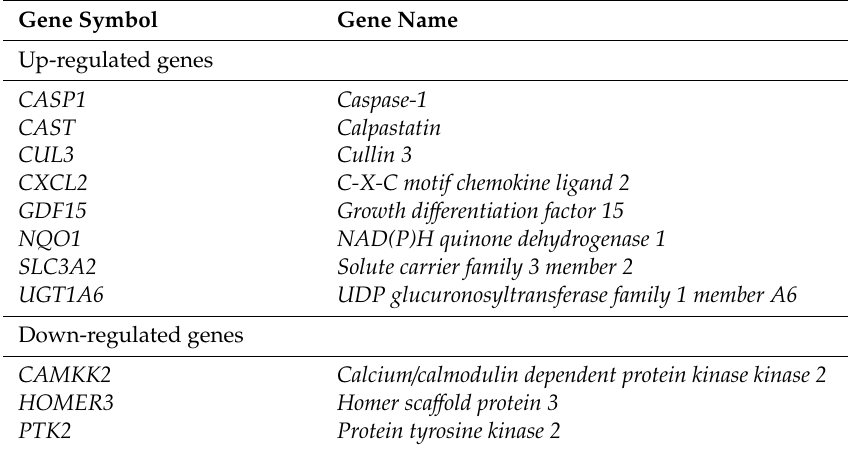
Table 2. List of NaHS-modulated keratinocyte genes previously shown to be targeted by sulfide-containing compounds. The list of genes identified as being modulated by NaHS in cultured epidermal cell sheets was crossed with the list of genes previously shown to be targeted by hydrogen sulfide-containing compounds according to the CTD database